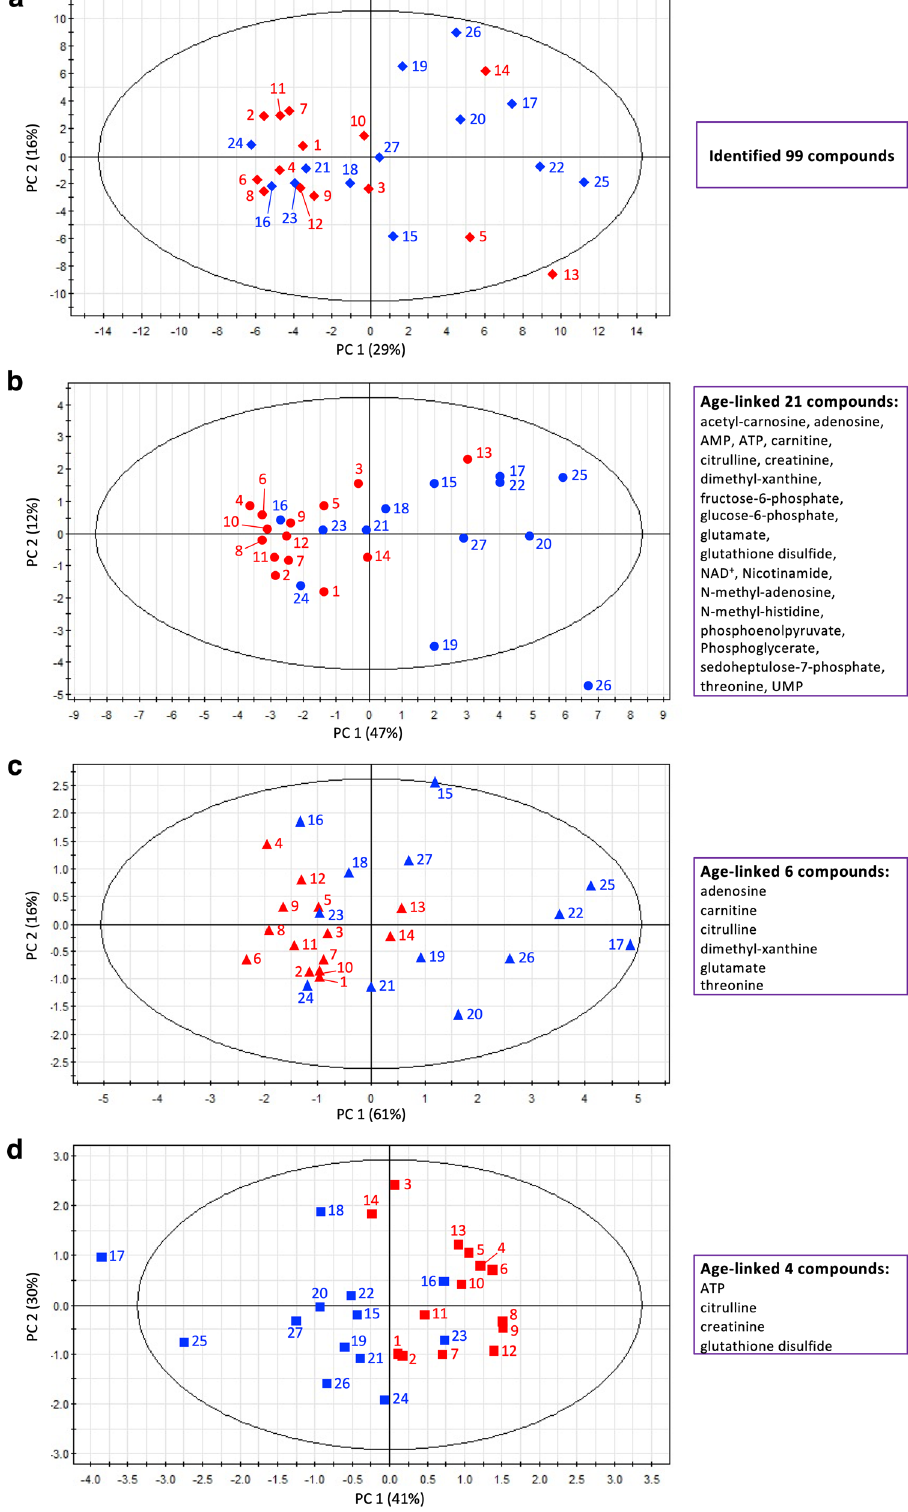
Figure 3. PCA of age-linked salivary compounds. ( a ) Taken together, all 99 identified metabolites cannot separate young (blue) and elderly subjects (red). ( b ) Oral aging may be detected by PCA of 21 age-linked metaoblites in a 2D manner (see text for explanation). Elderly subjects (no. 1–12, 14) are located in the negative domain of the x-axis, while young subjects (no. 15, 17–20, 22, 25–27) are located in the positive domain. However, four young subjects 16, 21, 23 and 24, appear in the negative domain, while elderly subject 13 is located in the positive domain. These positions parallel heatmap data (Fig. 4) which show metabolite levels for individual subjects. ( c ) Six metabolites can separate young and elderly subjects. ( d ) Even four metabolites largely separate